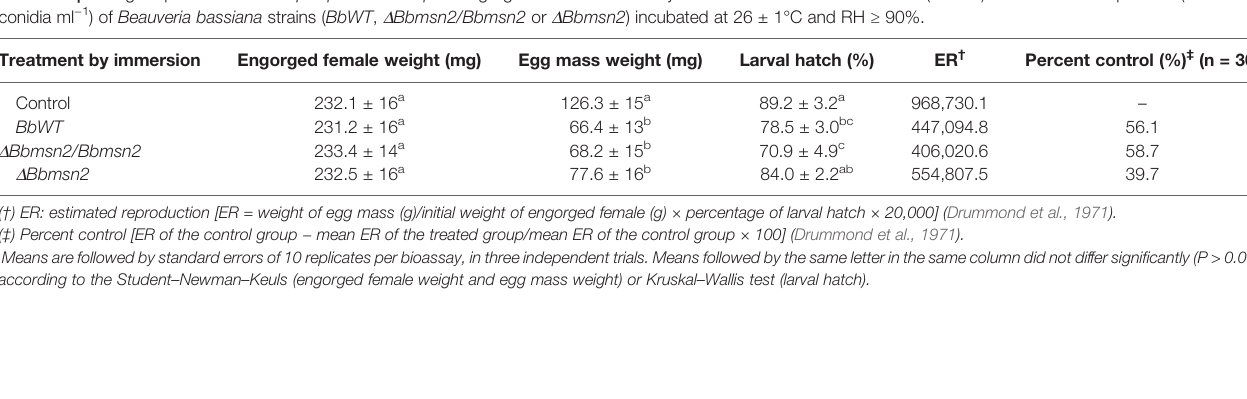
TABLE 1 | Biological parameters of Rhipicephalus microplus engorged females treated by immersion in Tween 80 ® 0.01% (control) or in conidial suspension (2.0 × 10 8 conidia ml − 1 ) of Beauveria bassiana strains ( BbWT , D Bbmsn2/Bbmsn2 or D Bbmsn2 ) incubated at 26 ± 1°C and RH ≥ 90%.